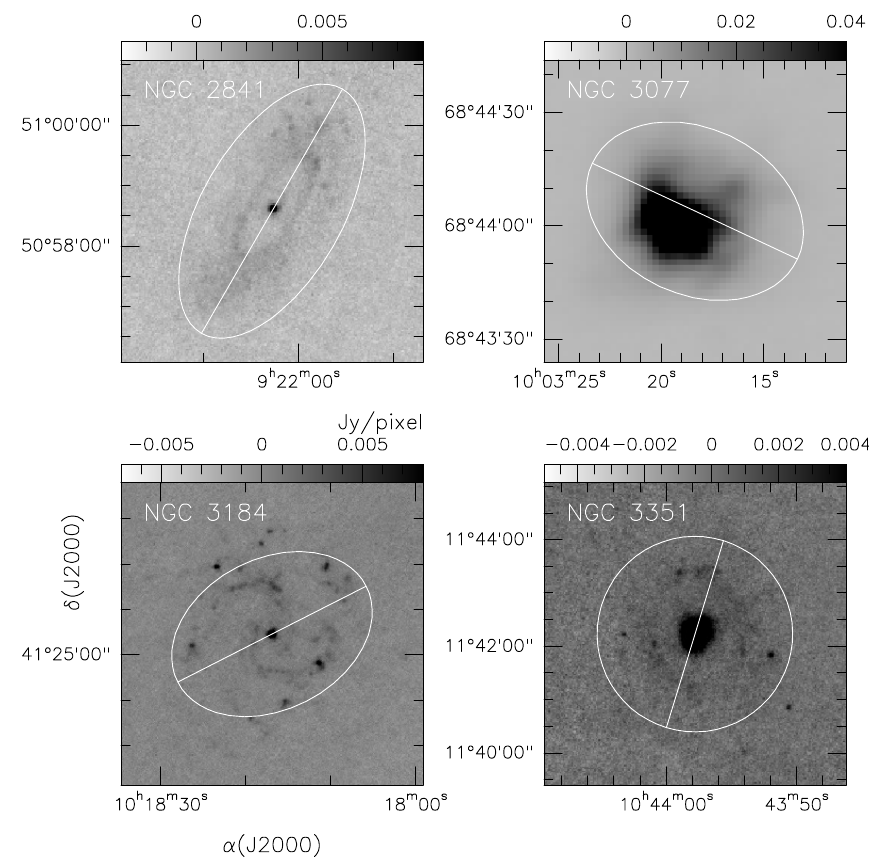
Figure 1. Images at 70 µ m from our galaxy sample. The white ellipse is used to derive the infrared flux density (see Section 3.1). The white line indicates the major-axis of each